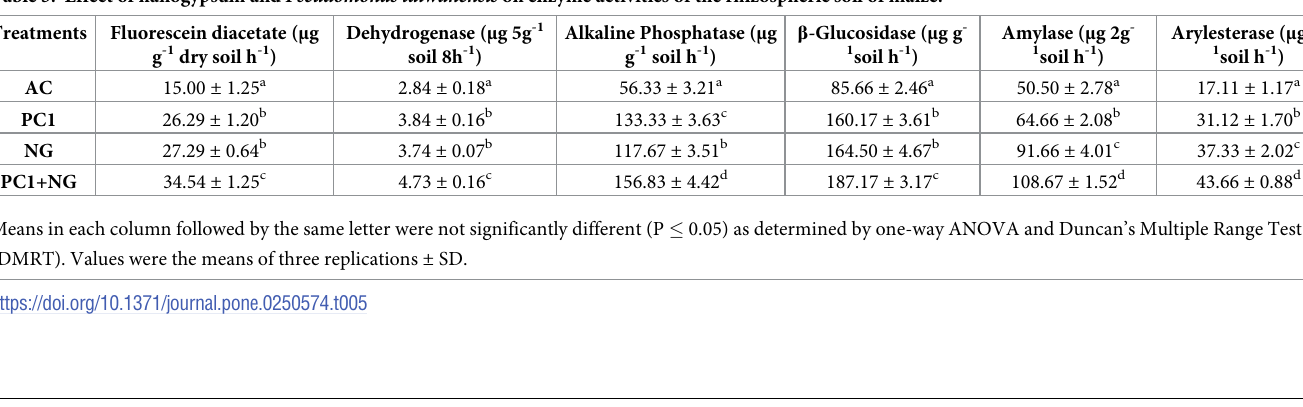
Table 5. Effect of nanogypsum and Pseudomonas taiwanensis on enzyme activities of the rhizospheric soil of maize. Treatments Fluorescein diacetate ( μ g g -1 dry soil h -1 )